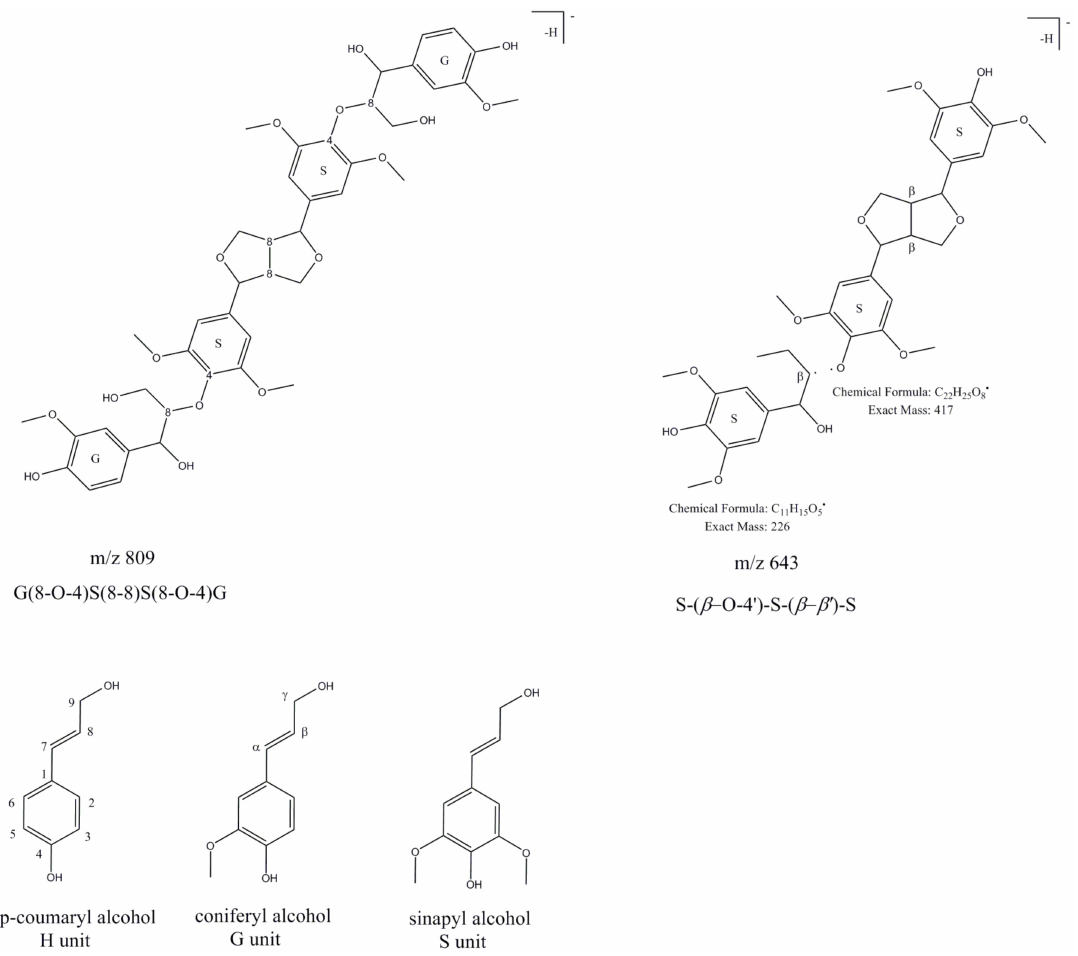
Figure 6. Lignin